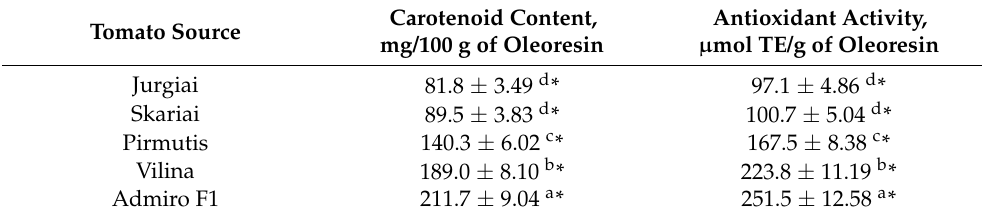
Table 1. The antioxidant activity of different lipophilic SCE-CO 2 extracts. * Different letters above the columns of the same color indicate significant differences between the measured values ( p ≤